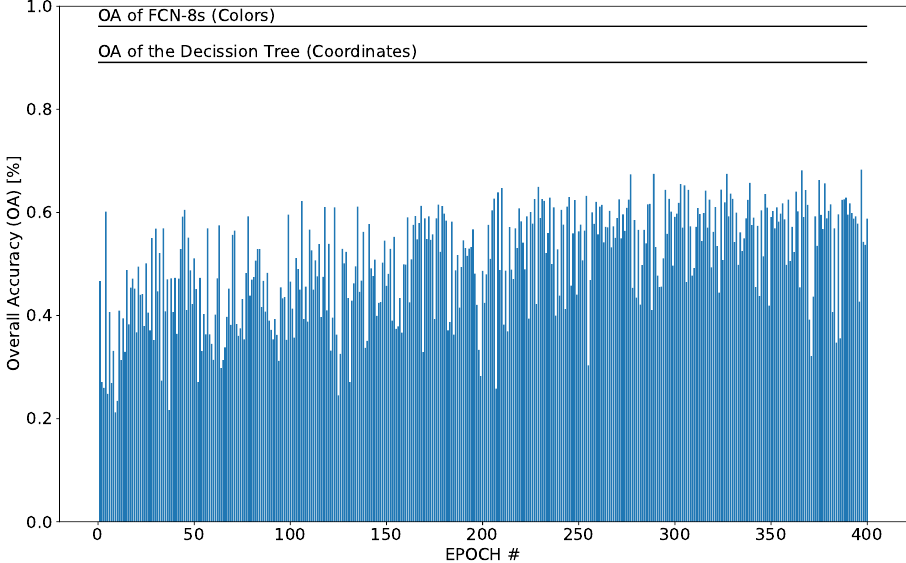
Figure 9. Overall accuracy for the GSCNN model that is trained on coordinates and colors, and uses a weighted loss, after each epoch. Table 4. Per class metrics for the GSCNN, the FCN-8s, and the decision tree. Values in bold format are the highest numbers for corresponding metric, with the exception for baseline A. See Appendix B for the confusion